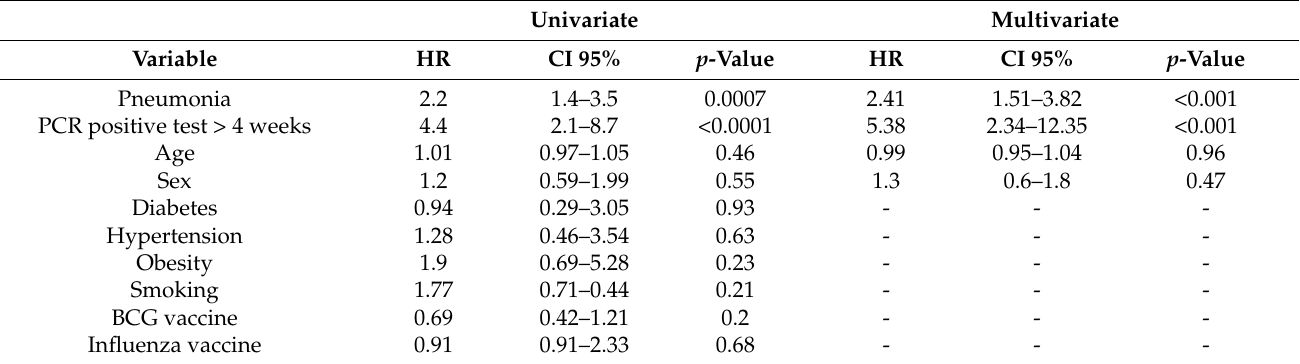
Table 3. Univariate and multivariate hazard ratios for post-COVID-19 pulmonary fibrosis. Univariate